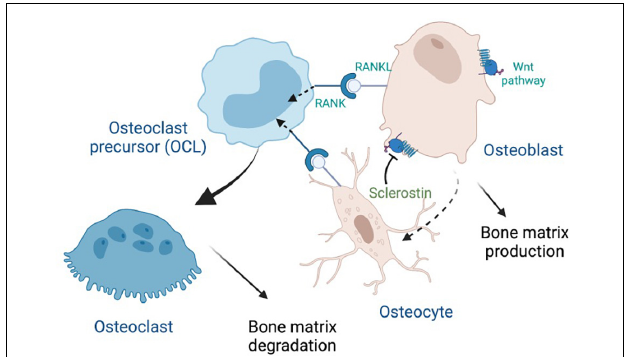
FIGURE 2 | Crosstalk between major bone cells through RANK, RANKL and Wnt signaling, with inhibition by sclerostin. Osteoprotegerin (OPG), which is secreted by osteoblasts, can also bind to RANKL (not